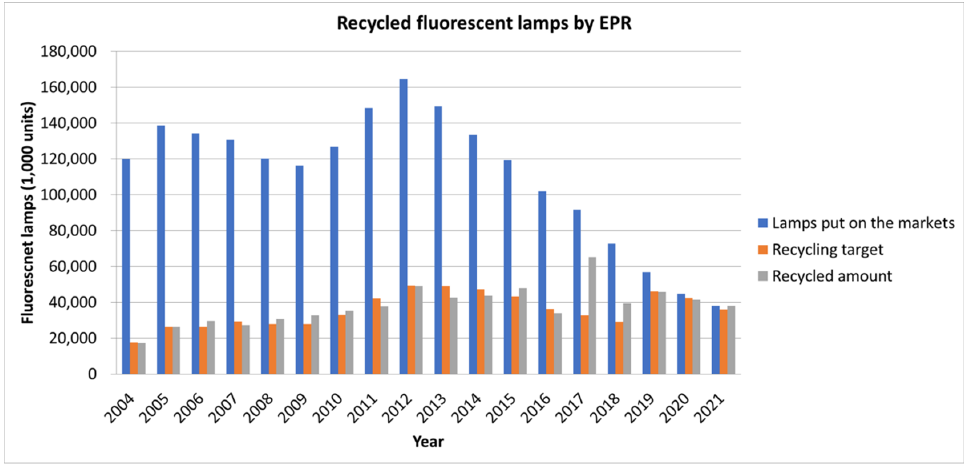
Figure 3. The recycling rates and mandatory recycling targets of end ‐ of ‐ life fluorescent lamps by EPR in South Korea between 2004 and 2021. in South Korea between 2004 and